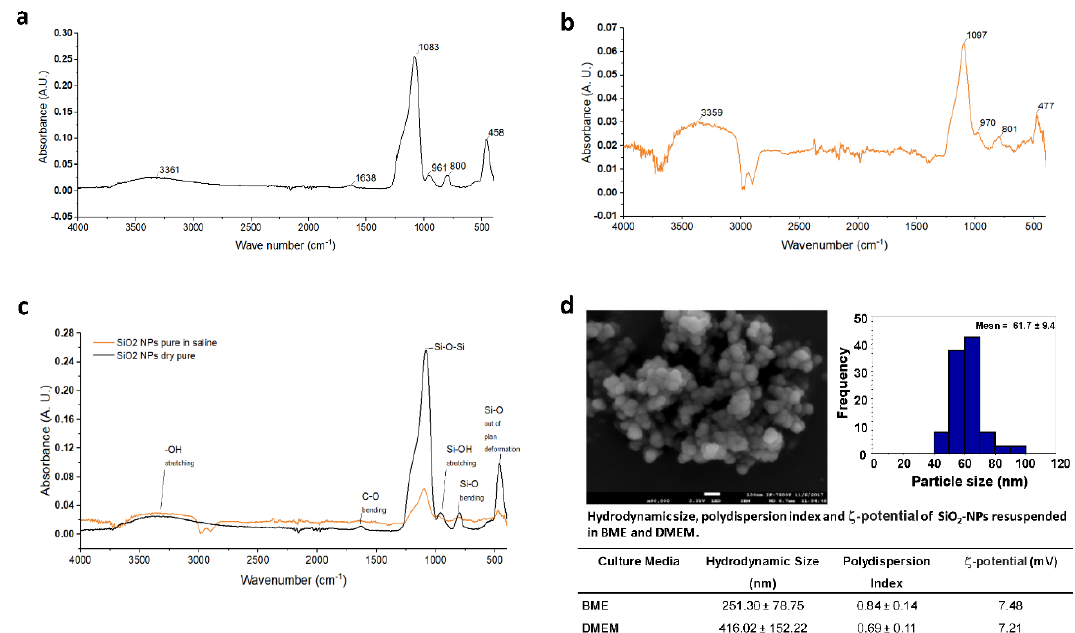
Figure 1. Characterization of SiO 2 -NPs by ATR-FTIR spectroscopy, scanning electron microscopy, and ζ -potential. ( a ) An infrared spectrum of SiO 2 -NPs as pure powder. IR spectral bands correspond to 458 cm − 1 for Si-O out of plane deformation; 800 cm − 1 for Si-O bending, 961 cm − 1 for Si-OH stretching, 1083 cm − 1 for Si-O-Si asymmetric stretching, 1638 cm − 1 for C-O bending, 3361 cm − 1 of -OH. ( b ) An infrared spectrum of SiO 2 -NPs suspended in saline solution. ( c ) Comparison of spectral bands of pure powder SiO 2 -NPs vs. suspended in saline. ( d ) Representative image of the scanning electron microscopy and ζ -potential values of SiO 2 -NPs suspended in BME and DMEM. The SEM image shown corresponds to 80,000 × , scale bar 100 nm.